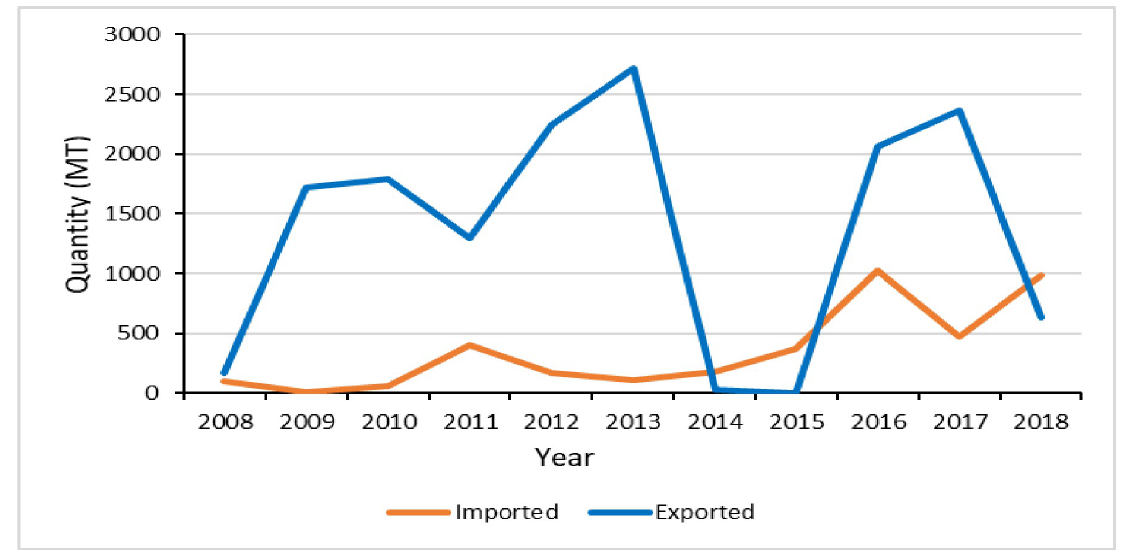
Fig 2. Groundnut export and import of Ghana; data source